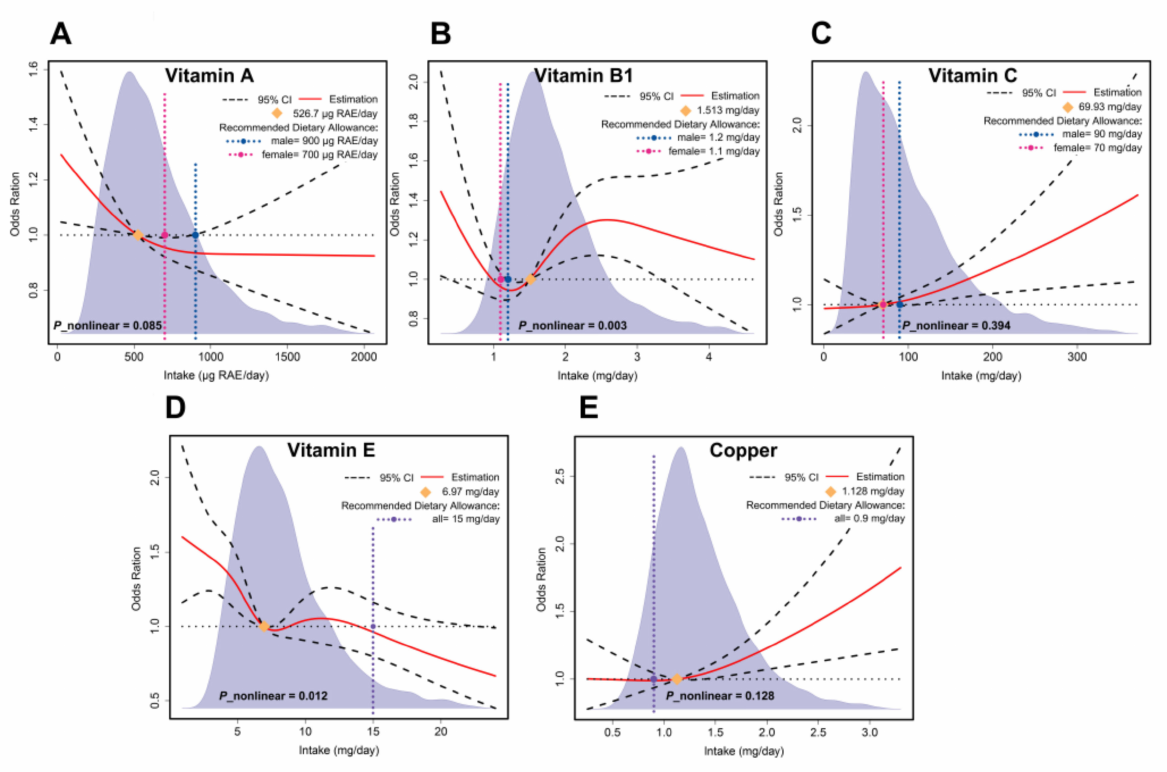
Figure 4. The RCS results for the micronutrients: ( A ) RCS results for vitamin A; ( B ) vitamin B1; ( C ) vitamin C; ( D ) vitamin E; ( E )